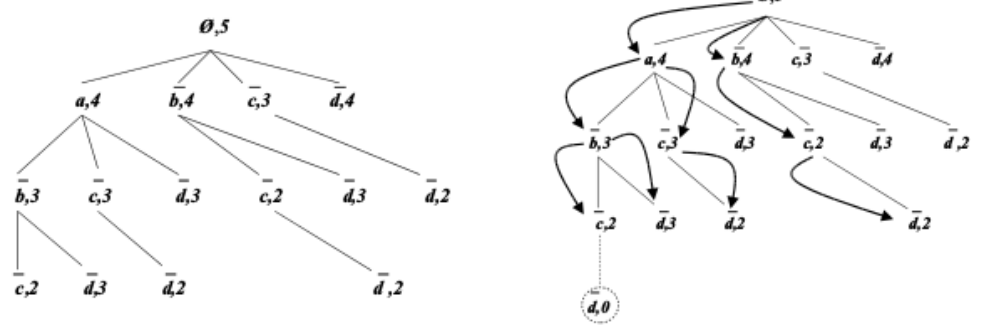
Figure 2. ( Left ): The prefix tree containing strict subsets of abcd . ( Right ): The bottom-most node d (encircled) presents the candidate literalset abcd generated from frequent literalsets abc and abd . The support value associated to this node is initialized to 0. The arrows show subsets that have to be